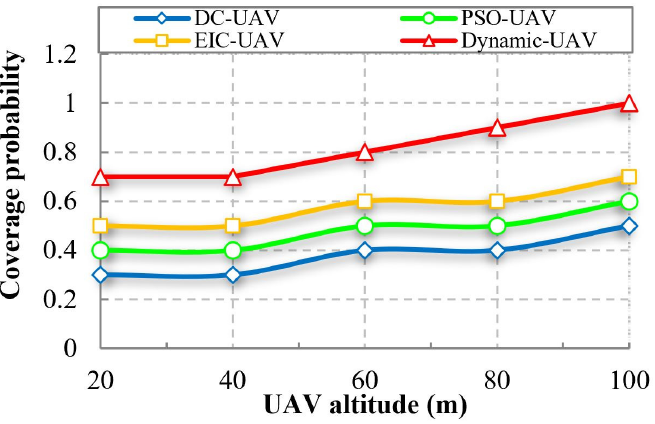
Figure 12. The altitude of UAVs vs. coverage probability.